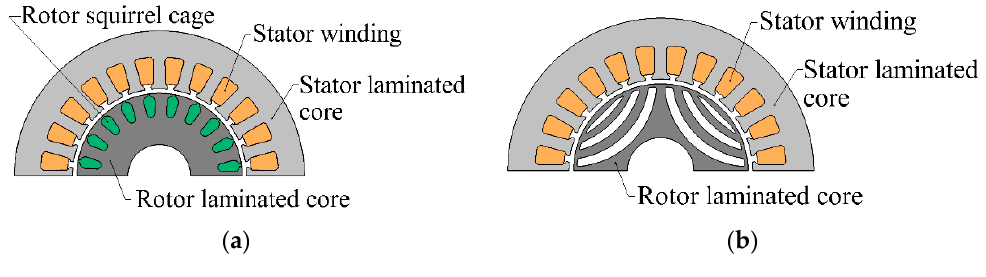
Figure 1. Machine general design representations: ( a ) IM; ( b ) SynRM.